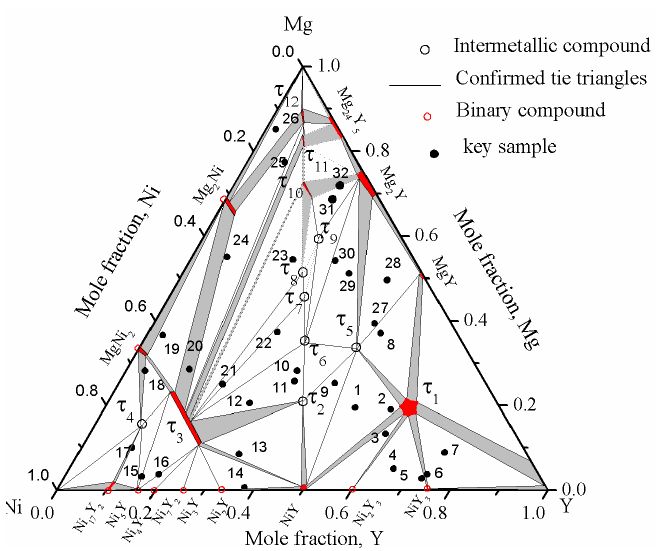
Figure 19. Isothermal section of the Mg-Ni-Y system at 673 K for the whole